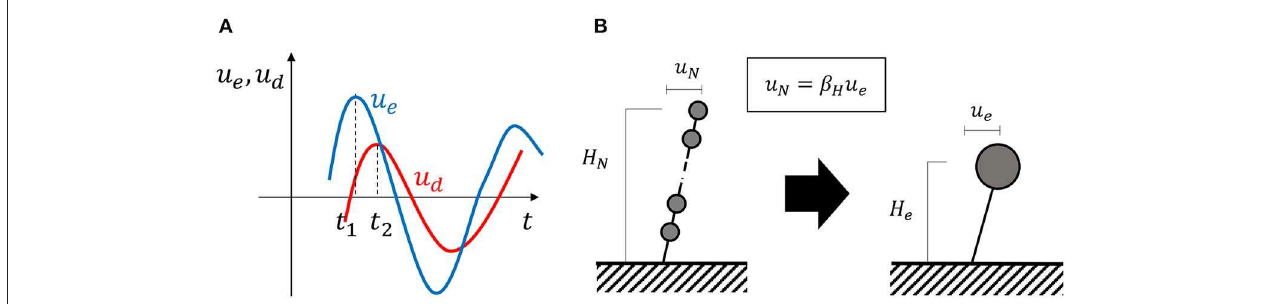
FIGURE 6 | Time-history responses and height correction in SDOF transformation. (A) Times at maximum displacements and (B) Equivalent height in equivalent SDOF